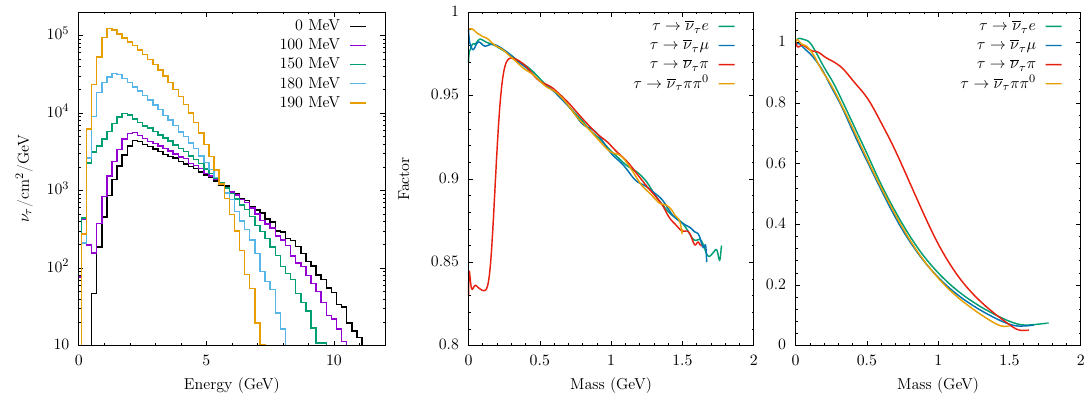
Figure 4 . The (cid:13)uxes of heavy neutrinos from D + ! (cid:28) + N (left) are presented for di(cid:11)erent neutrino s masses and normalised to 10 20 POT at the ND. Only phase space e(cid:11)ects are considered here. For each di(cid:11)erent value of the neutrino mass, information on the start and end point of the spectrum and the peak of the (cid:13)ux are extracted and used to reshape the (cid:23) (cid:28) spectrum. We show the distortion factors used in the scaling process for the channel producing (cid:23) (cid:28) : the energy range normalised to 20 GeV (middle) and the inverse of the peak re-scaling